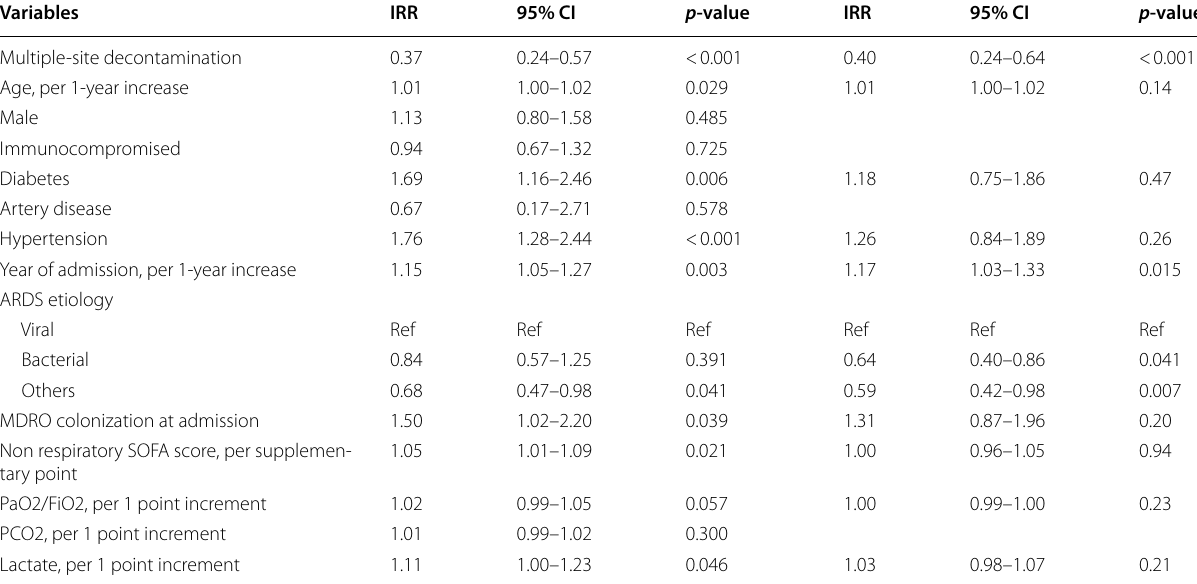
ARDS: acute respiratory distress syndrome; SOFA: Sequential Organ Failure Assessment; MDRO: multidrug-resistant microorganisms; ICU: intensive care unit; ECMO: extra corporeal membrane